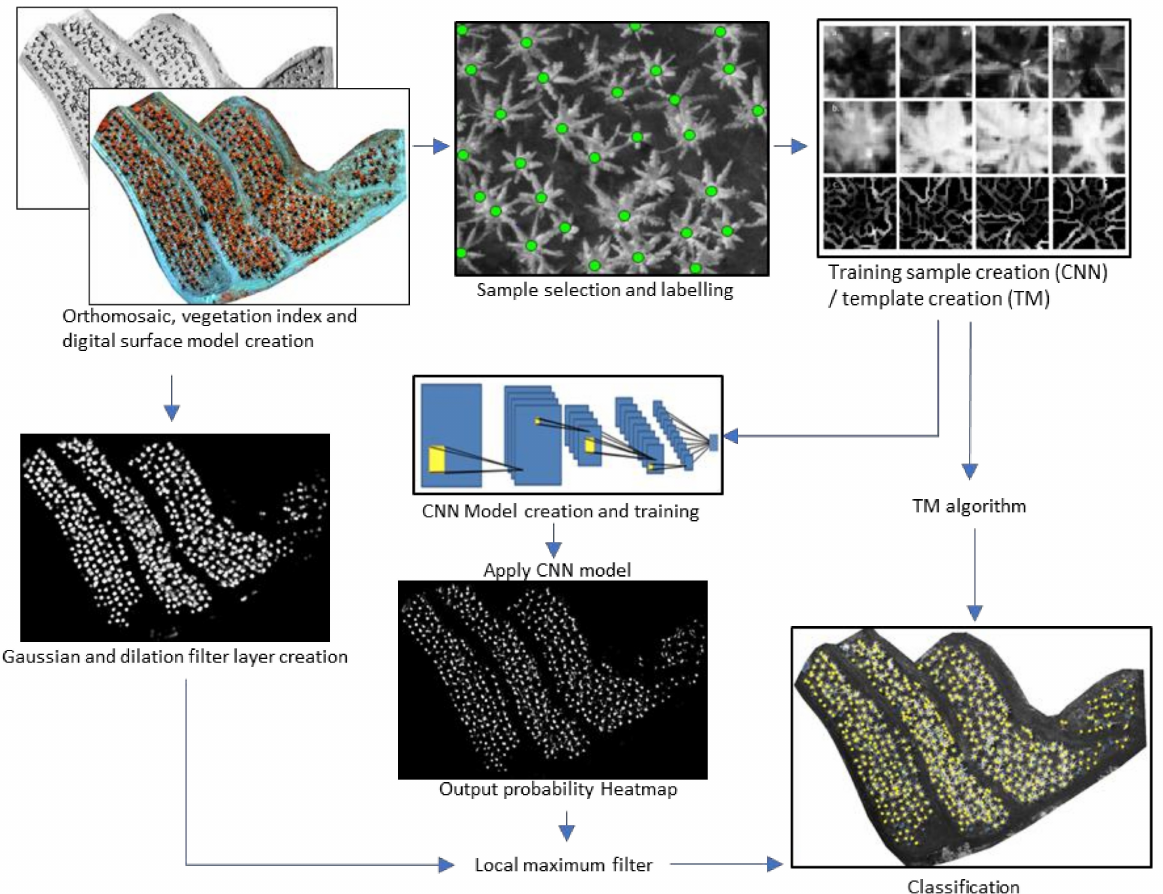
Figure 3. Overview of the main components of the image classification workflow within the eCognition Developer software. Orthomosaic classification was carried out using convolutional neural network (CNN), template matching (TM), and local maximum filter (LMF)